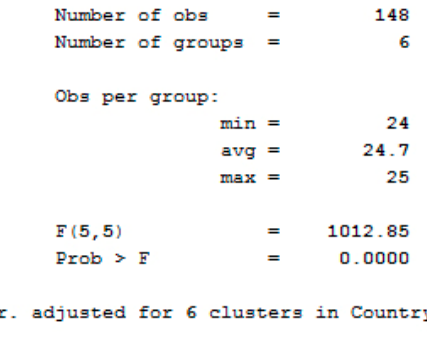
FE model, robust errors were used.